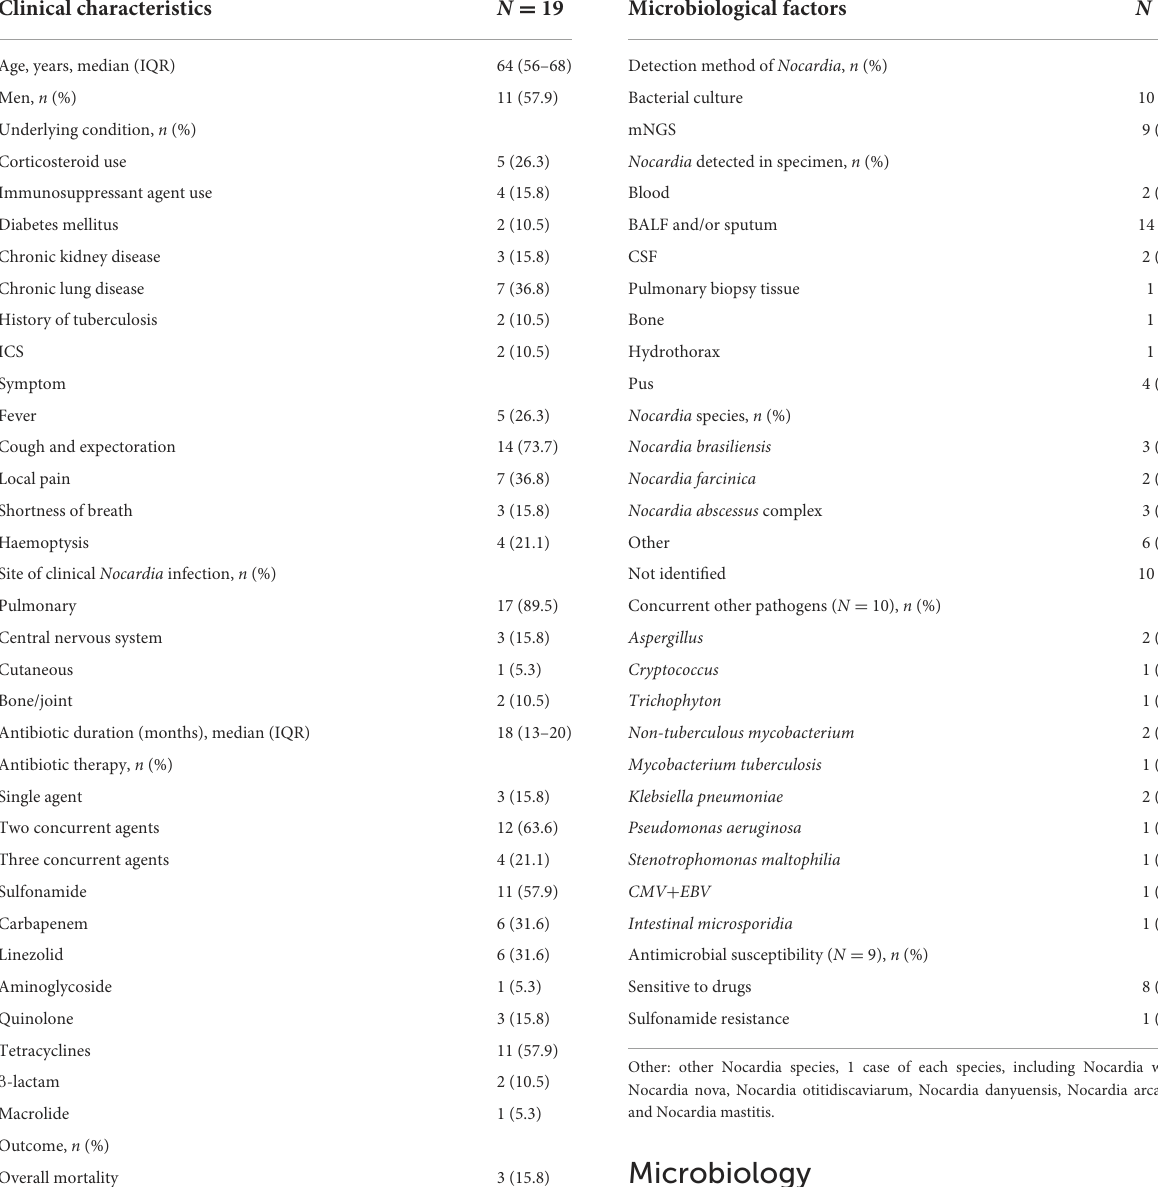
TABLE 2 Clinical characteristics of 19 cases of Nocardia infection. TABLE 3 Microbiological factors of 19 cases of Nocardia